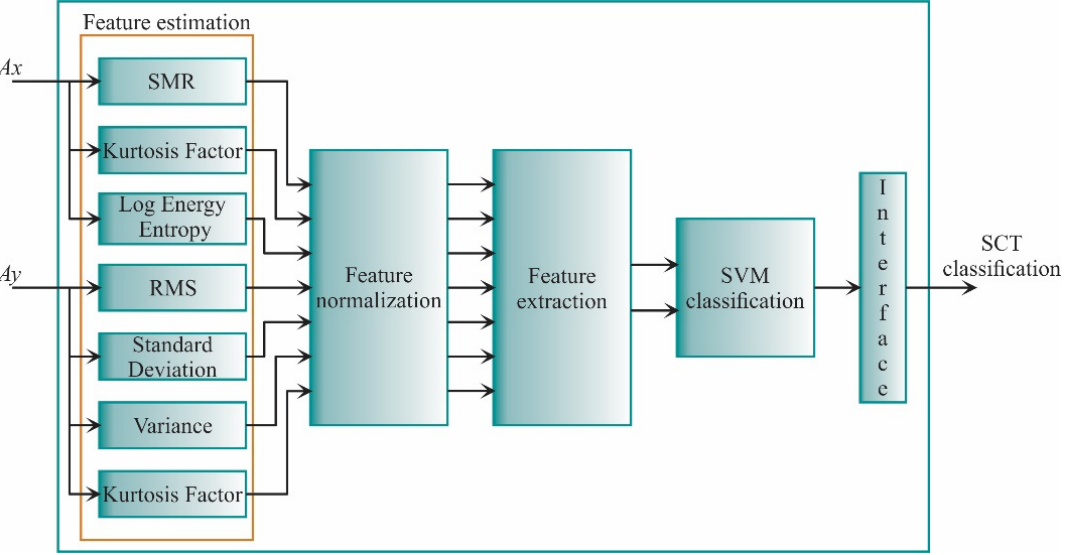
Figure 12. The principal architecture of the FPGA-based processor.